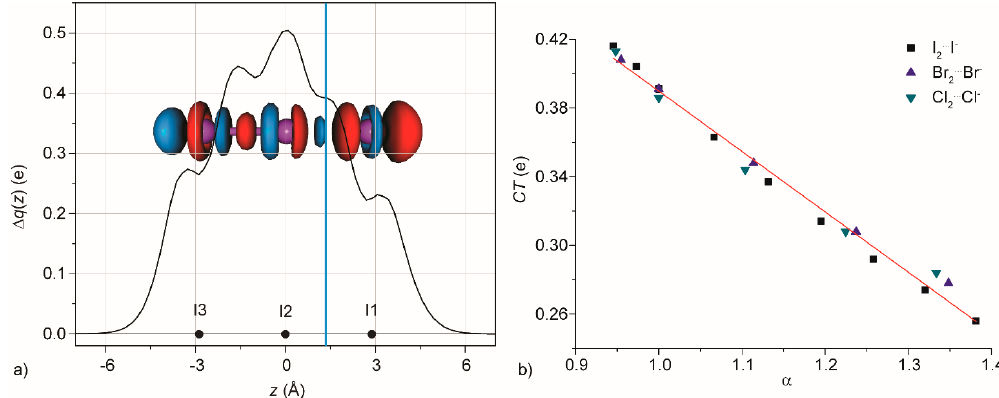
Figure 5. ( a ) Charge Displacement function for I 3 − . The black dots represent the z coordinate of the atoms. The light blue vertical line identifies the boundary between the two fragments. Overprint: contour map of the change of electronic density upon formation of the complex I 3 − from I 2 and I − . The direction of the charge flow is red → blue. Density value at the isosurfaces: ±2.5 me/bohr 3 ; ( b ) Dependence of charge transfer (CT) on α (d X1–X2 / d X2–X3 ) for trihalide systems. The black line is the best linear fit (CT = 0.73 – 0.34 α , r 2 = 0.9694). (Reproduced from Reference 61 Copyright © 2020, John Wiley and Sons, with